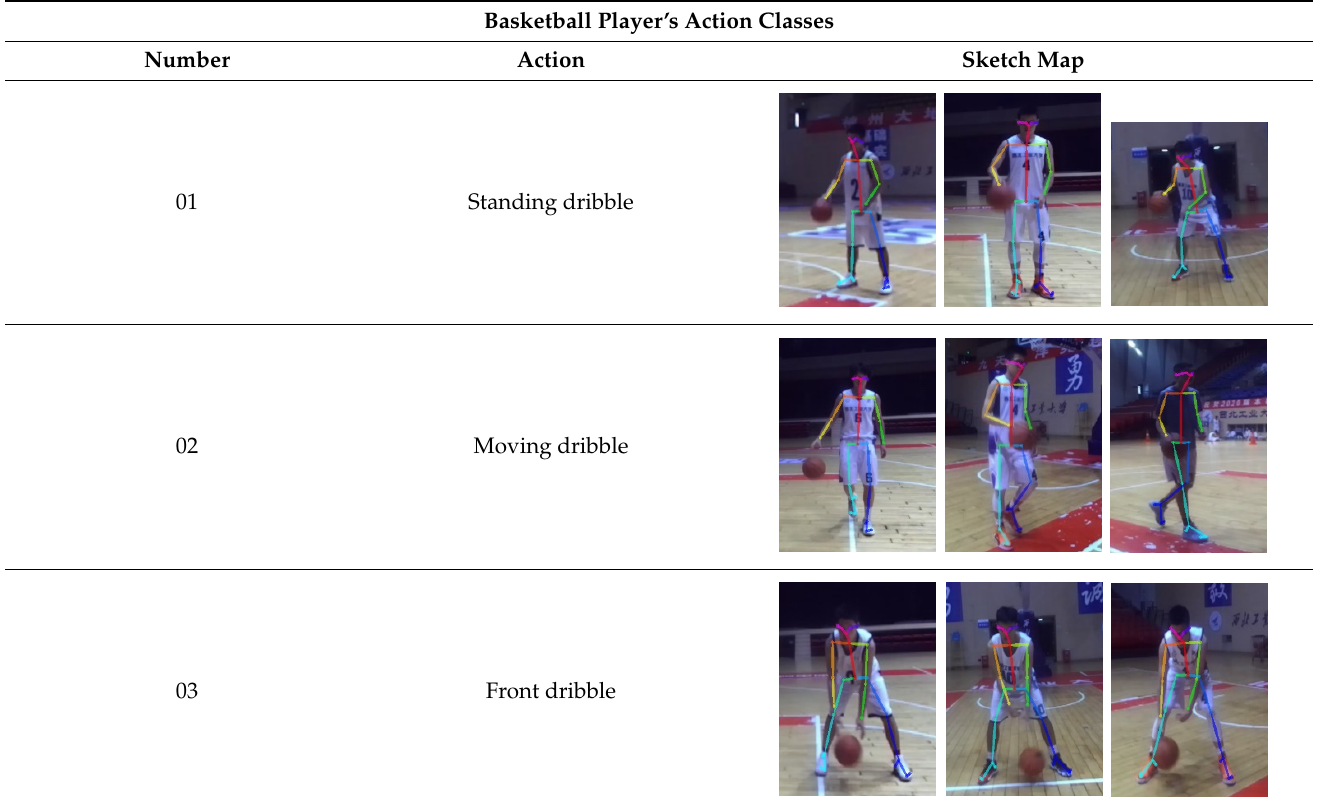
Table 2. The list of all 12 basketball action categories.